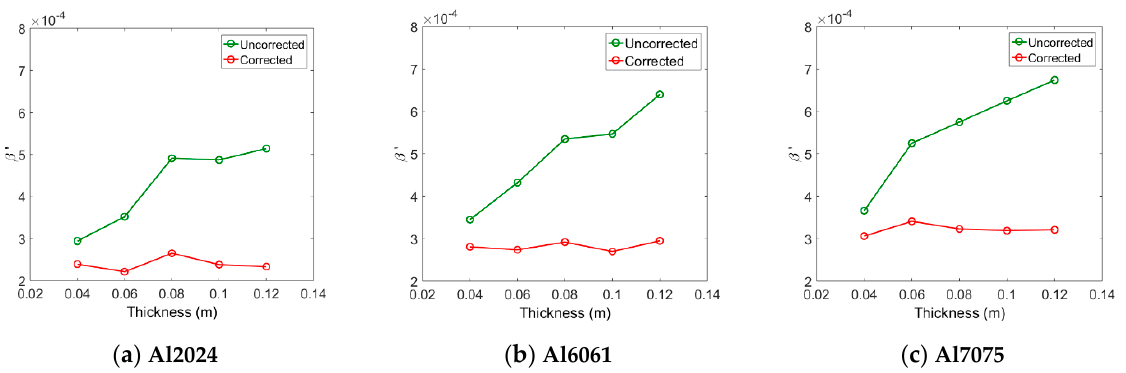
Figure 8. Measured β′ before and after all corrections for three different aluminum systems.